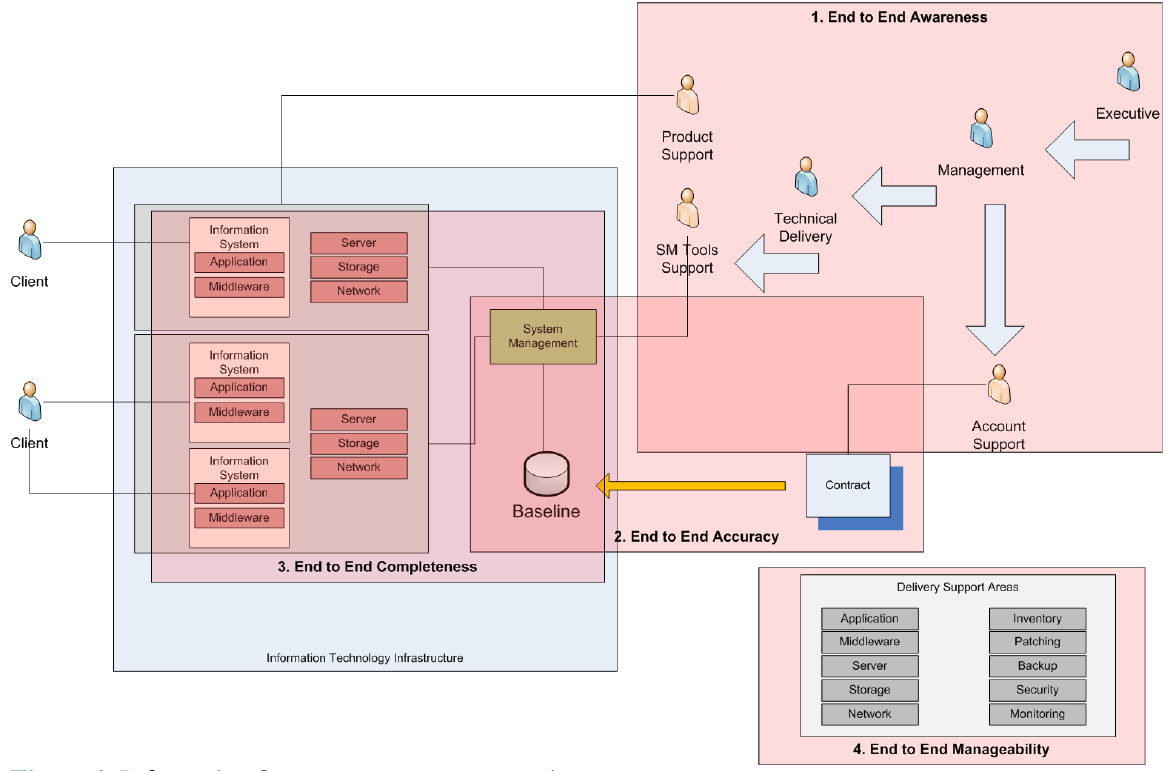
Figure 1. Information System management scenario